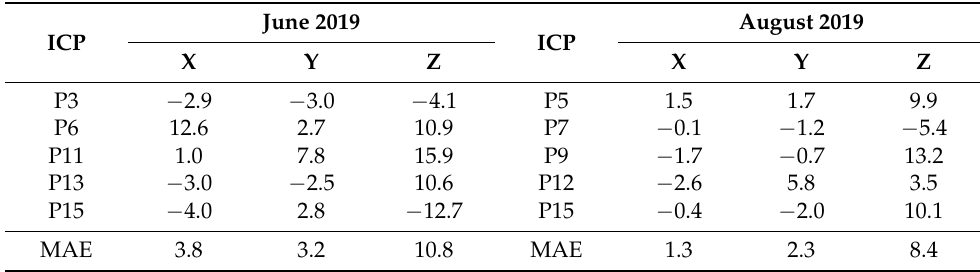
Table 4. Positional errors between ICP coordinates estimated from SfM processing and ICP observed (values in centimetres), and mean absolute error (MAE).